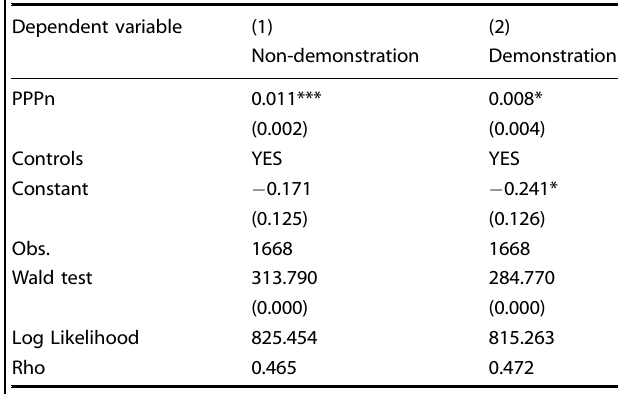
Table 7. Effect of